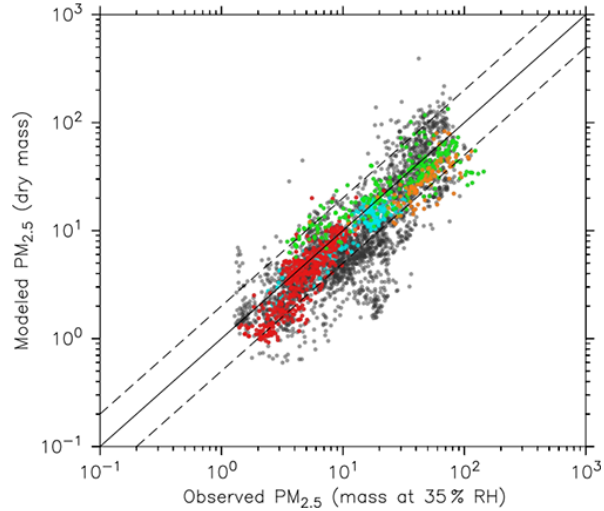
Figure 19. Scatterplots of PM 2 . 5 of model results versus data from Hammer et al. (2020) for the year 2010 (annual average, in µgm − 3 ). Light blue, red, green and orange depict points located in Europe, North America, East Asia and South Asia, respectively. Grey points indicate the remaining parts of the world.